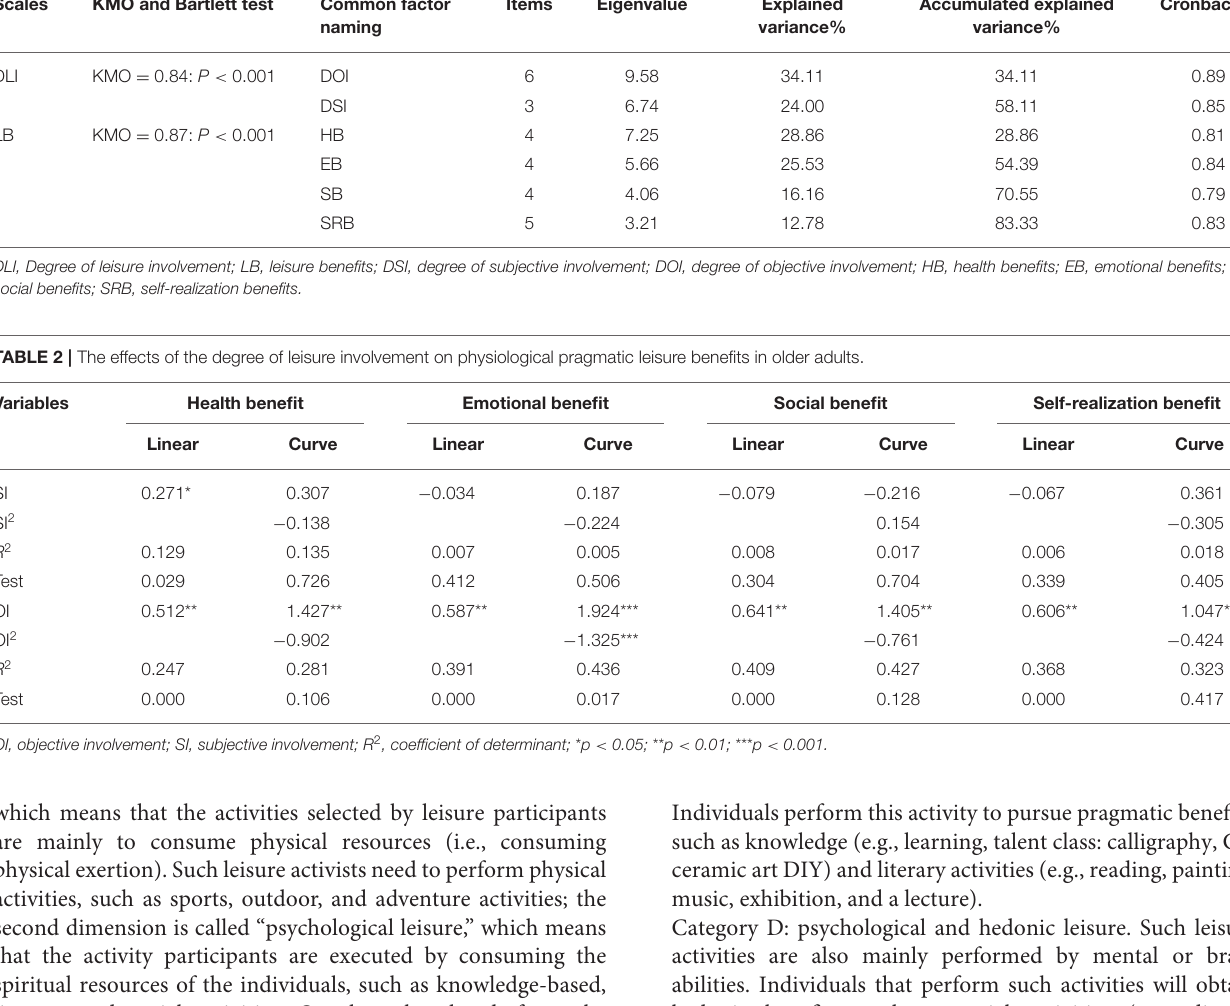
(1) Only the linear model can explain the impact of objective involvement on physiological and practical leisure